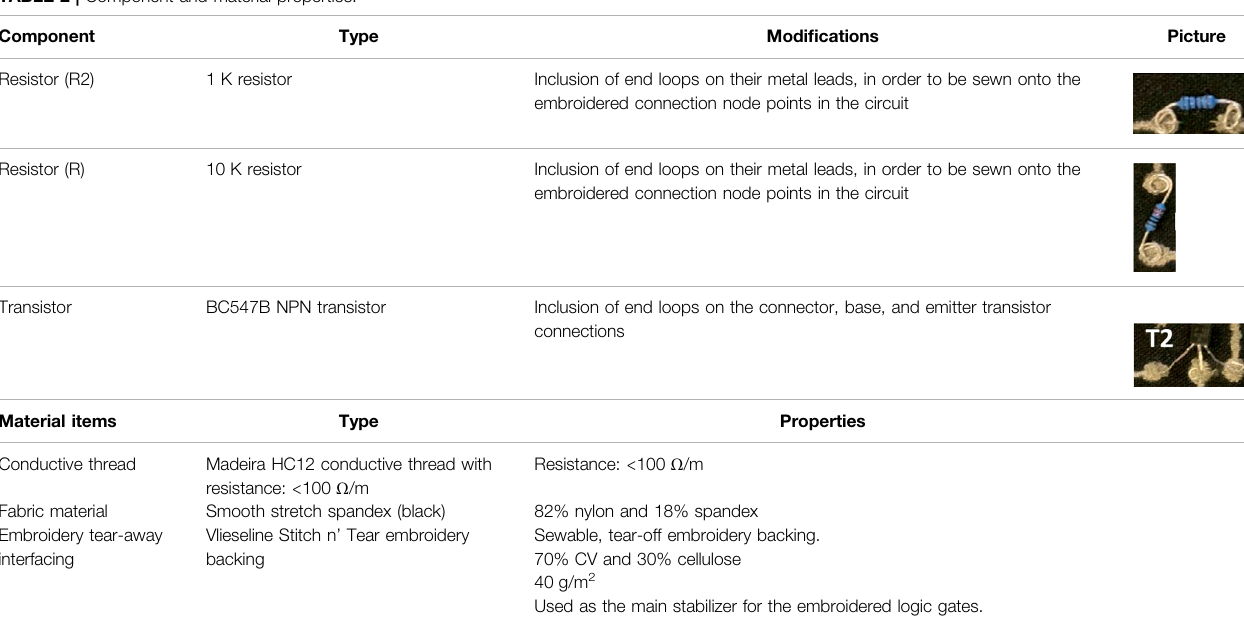
TABLE 2 | Component and material properties.